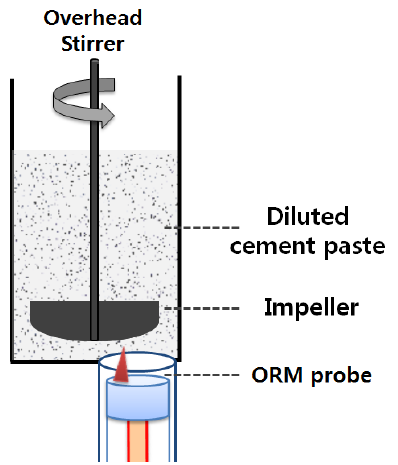
Figure 2. Bottom-up setup for